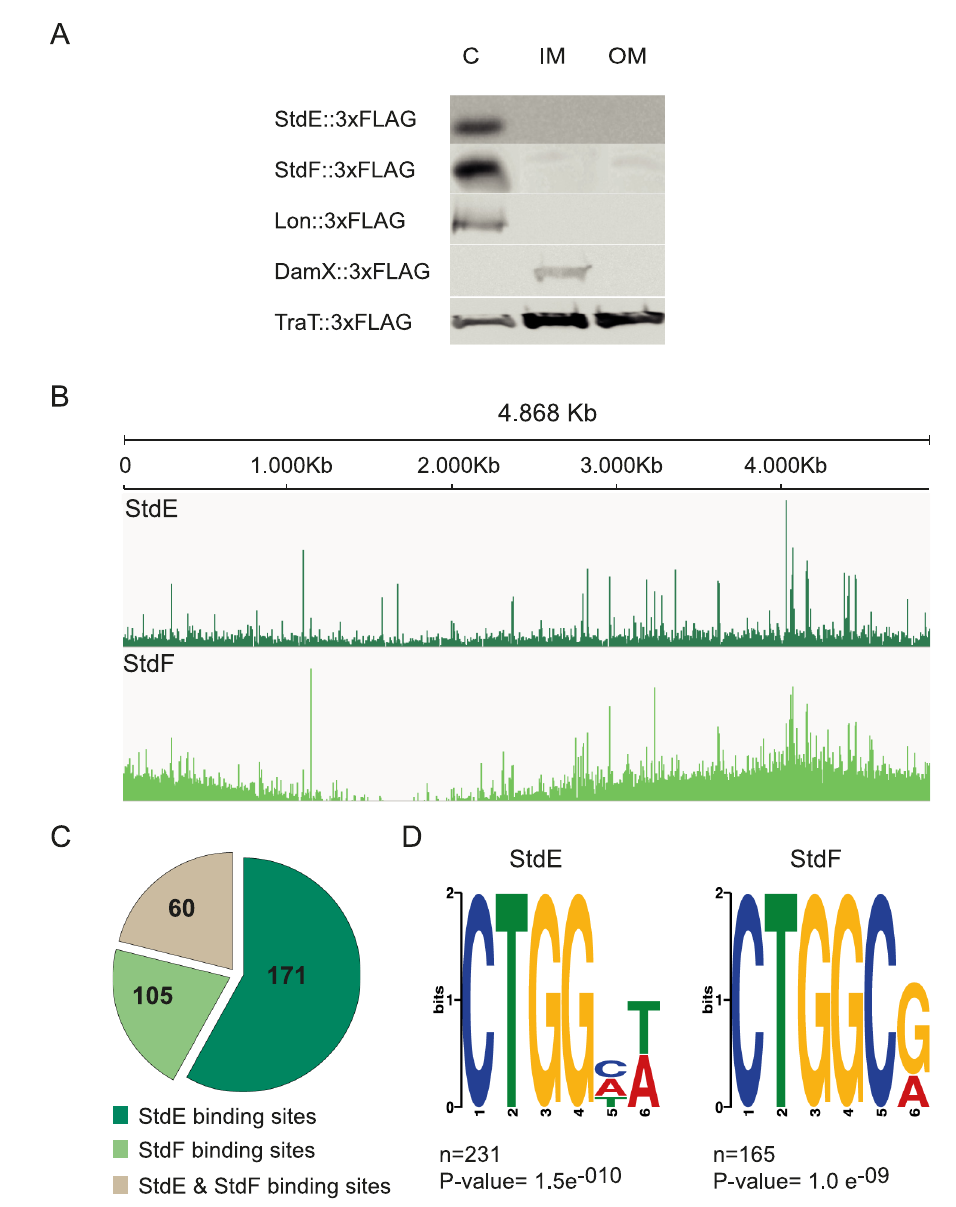
Fig 3. Genome-wide identification of StdE and StdF binding sites by ChIP-seq. A. Subcellular localization of StdE and StdF proteins in cellular fractions (cytoplasm (c), inner membrane (IM) and outer membrane (OM)) using 3xFLAG-tagged versions of the proteins (SV9324 and SV9325, respectively). Controls used for each fraction are Lon, DamX and TraT. B. Visualization of StdE and StdF ChIP-seq data using the Integrative Genomics Viewer (IGV) for S . Typhimurium SL 1344. StdE represents the difference between the StdE IP sample and the mock IP control and the same is valid for StdF. C. The pie chart shows the number of StdE, StdF and StdE & StdF binding sites along the Salmonella enterica genome. D. StdE and StdF binding motifs identified by